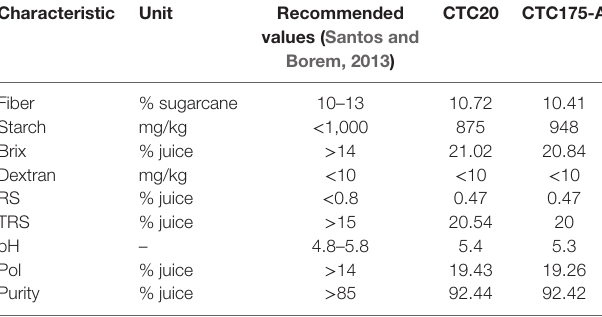
TaBle 6 | Results of sugarcane quality